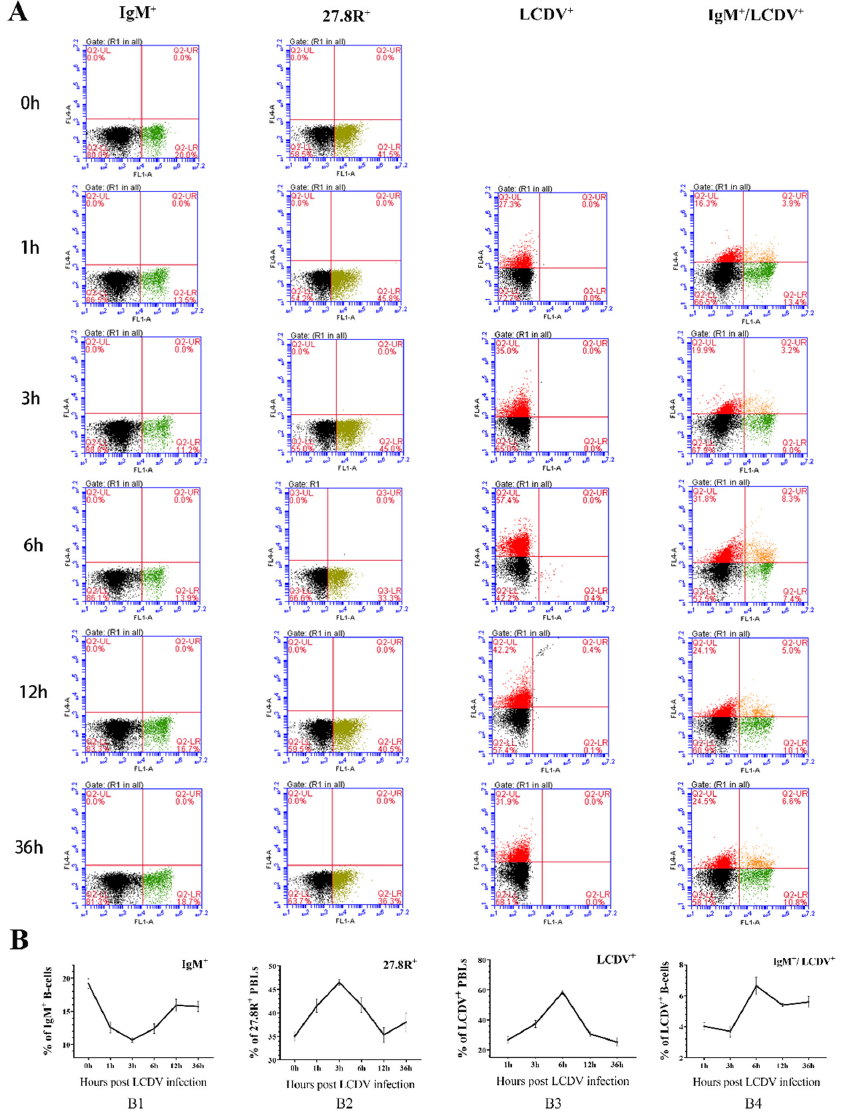
Figure 7. FACS analysis of the level of IgM + B-lymphocytes, 27.8R + PBLs, LCDV + PBLs and LCDV + /IgM + B-lymphocytes during the early phase of LCDV infection. ( A ) The proportion of various positive cells in PBLs at different time points as examples. ( B ) Time-course variations in the proportion of various positive cells in PBLs. Error bars represent SD ( n =